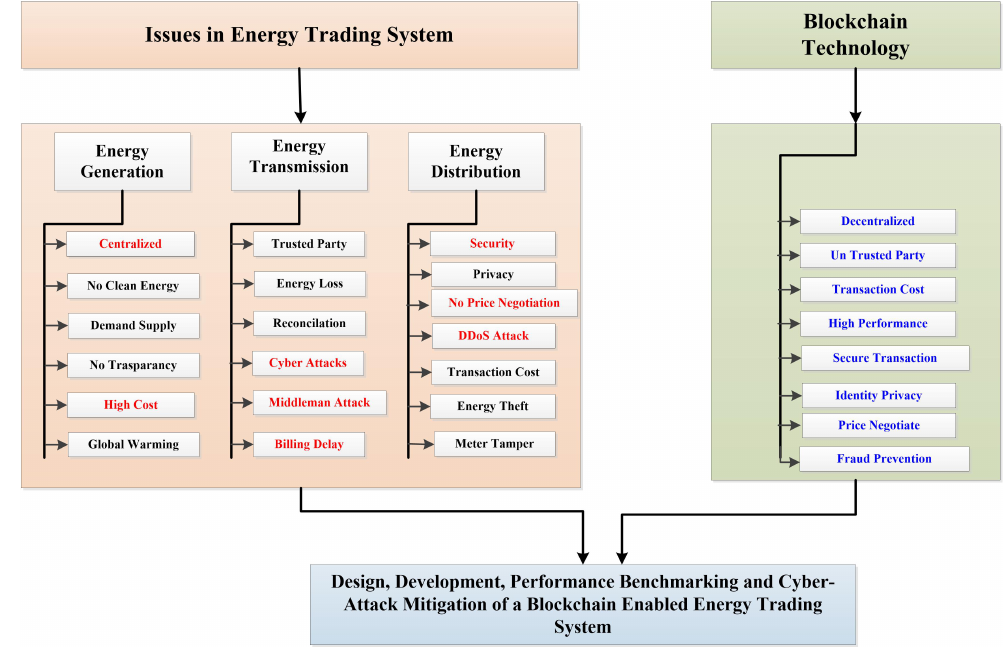
Figure 1. Issues in the traditional energy trading